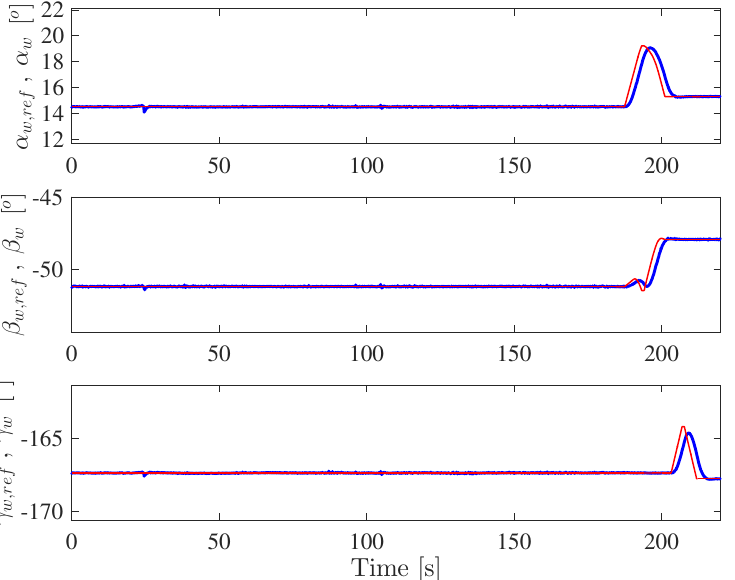
Figure 16. Performance of the WR angle teleoperation for the third experiment: user angular references in thin red line and actual angular values of the workpiece in thick blue line.